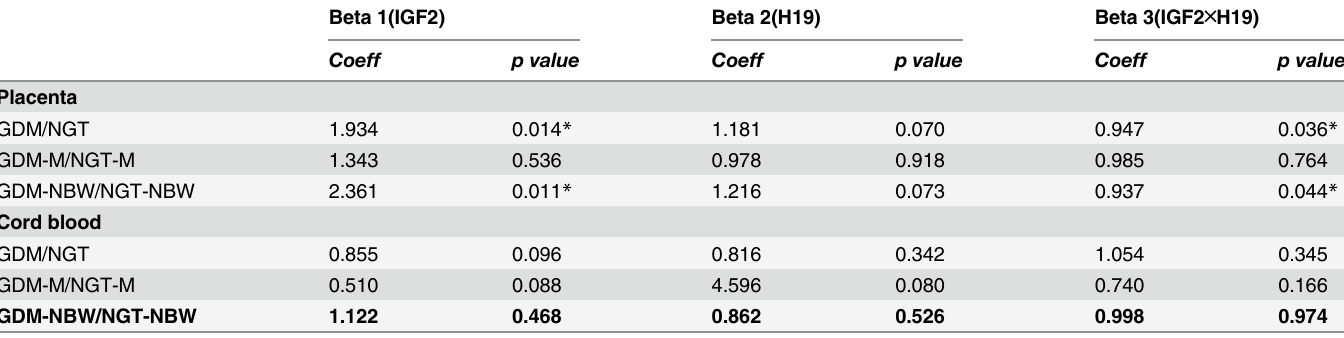
DMR had a significant negative associated with FPG and glucose of OGTT 1h and 2h ( p < 0.05, respectively). Analysis of the association among fetal birth weight related impact factor pre-pregnancy, anterpartum BMI and DNA methylation of IGF2/H19 DMRs was conducted. We found that DNA methylation of CpG sites 2 and 6 of IGF2 DMR showed negative relationship with pre- pregnancy and antepartum BMI ( p < 0.05).A positive association was seen among DNA meth- ylation of CpG19~22 of H19 DMR, pre-pregnancy and antepartum BMI ( p < 0.05). Table 2. The Coefficient Table of A Model with Interaction Term of IGF2 and H19